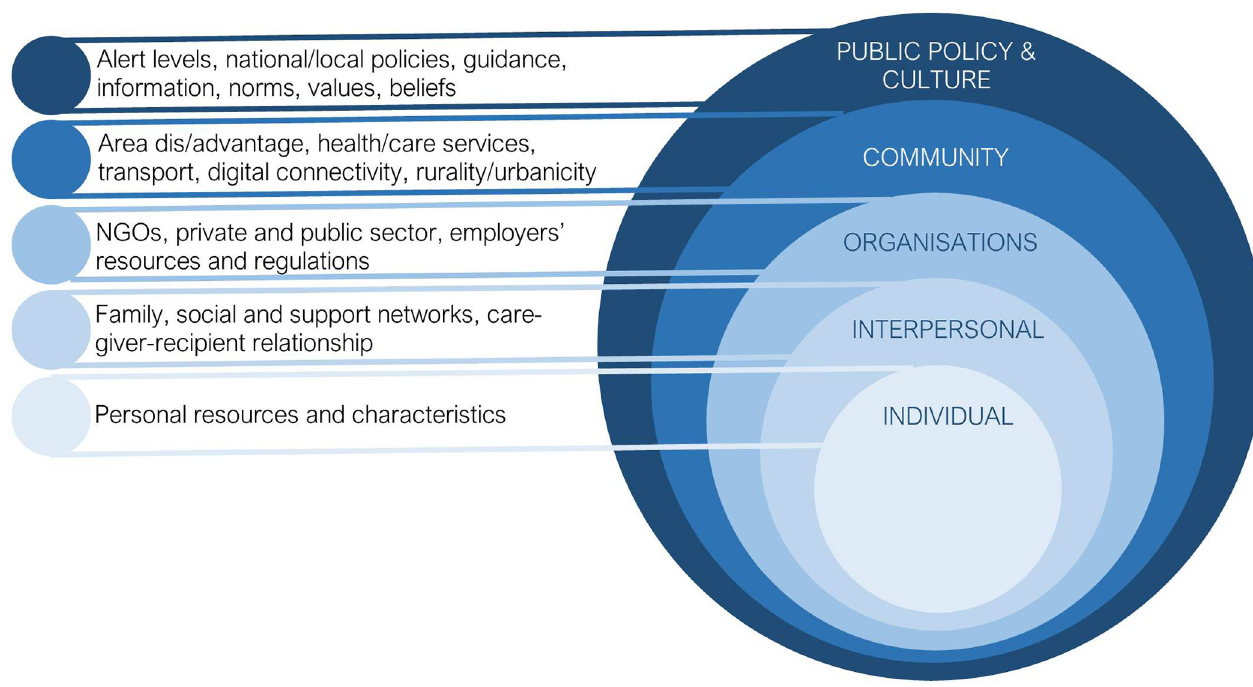
Fig 1. Human ecological model comprising inter-related systems that influence